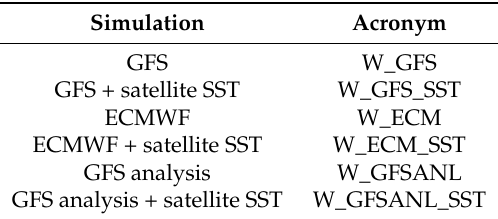
Table 1. List of all the simulations performed in the present work corresponding to different initializations (first column) and corresponding acronyms (second